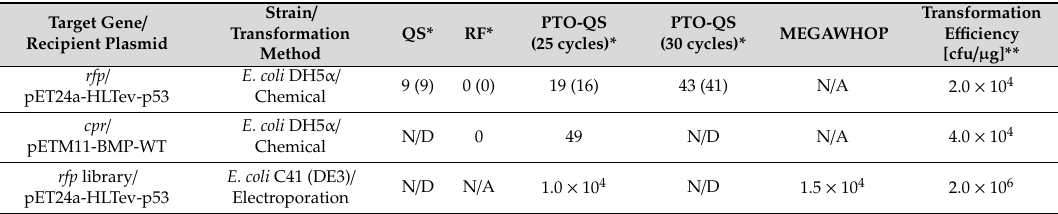
Table 2. Comparison of cloning e ffi ciencies: QS: QuickStep; RF: restriction-free (RF) cloning; PTO-QS: PTO-QuickStep (*Numbers in bracket represent RFP-expressing clones; **intact recipient plasmids were used as reference plasmids; N / A = not applicable; N / D = not determined). Target Gene / Recipient